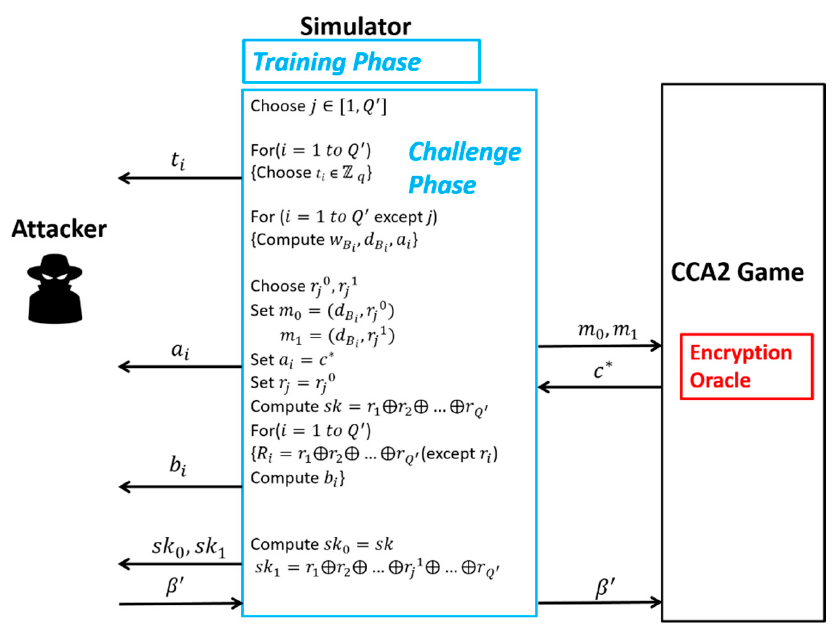
Figure A6. The session key security ( Q (cid:48) > 1 )